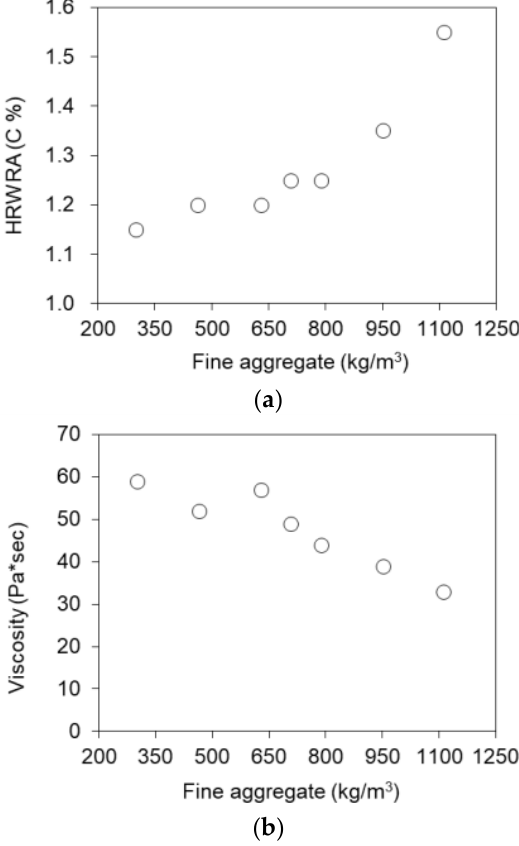
Figure 21. Mortar flow varied by volume of fine aggregate.